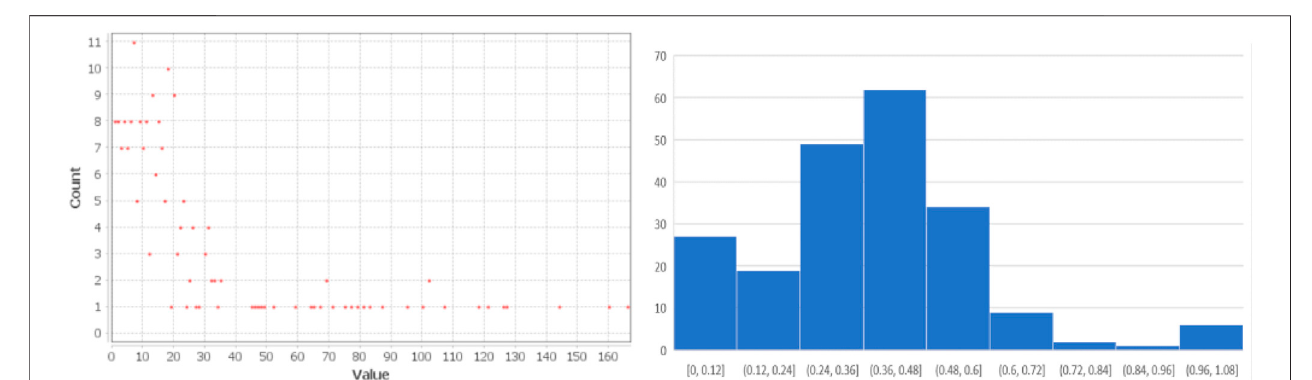
FIGURE 1 | Degree distribution and the cluster coef fi cient distribution of 2016.